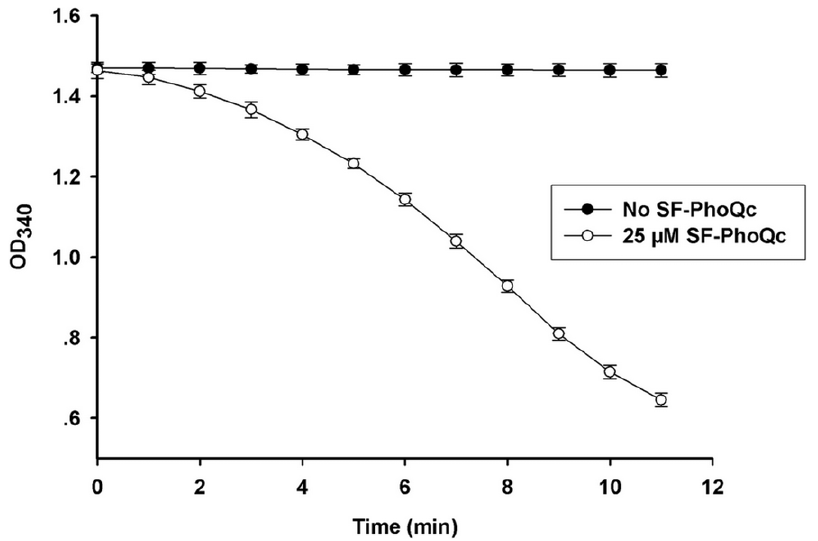
Figure 2. The activity of recombinant SF-PhoQc. The activity of SF-PhoQc from the Pyrophosphate Reagent was shown. All assays were conducted in a 96-well microplate spectrophotometer. The assay mixture (total volume was 200 m l) contained 25 mmol/L KCl, 2.5 mmol/L MgCl 2 , 2 mmol/L ATP, 1 mmol/L phosphoendpyruvate, 0.35 mmol/L NADH, 1.5 U/ml PK, 1.25 U/ml LDH and 50 mmol/L Tris-Cl (pH 8.0). Protein SF-PhoQc was added to a final concentration of 25 m mol/L to start the reaction. After SF-PhoQc was added, the A 340 value was recorded by SoftMax vision 4.8